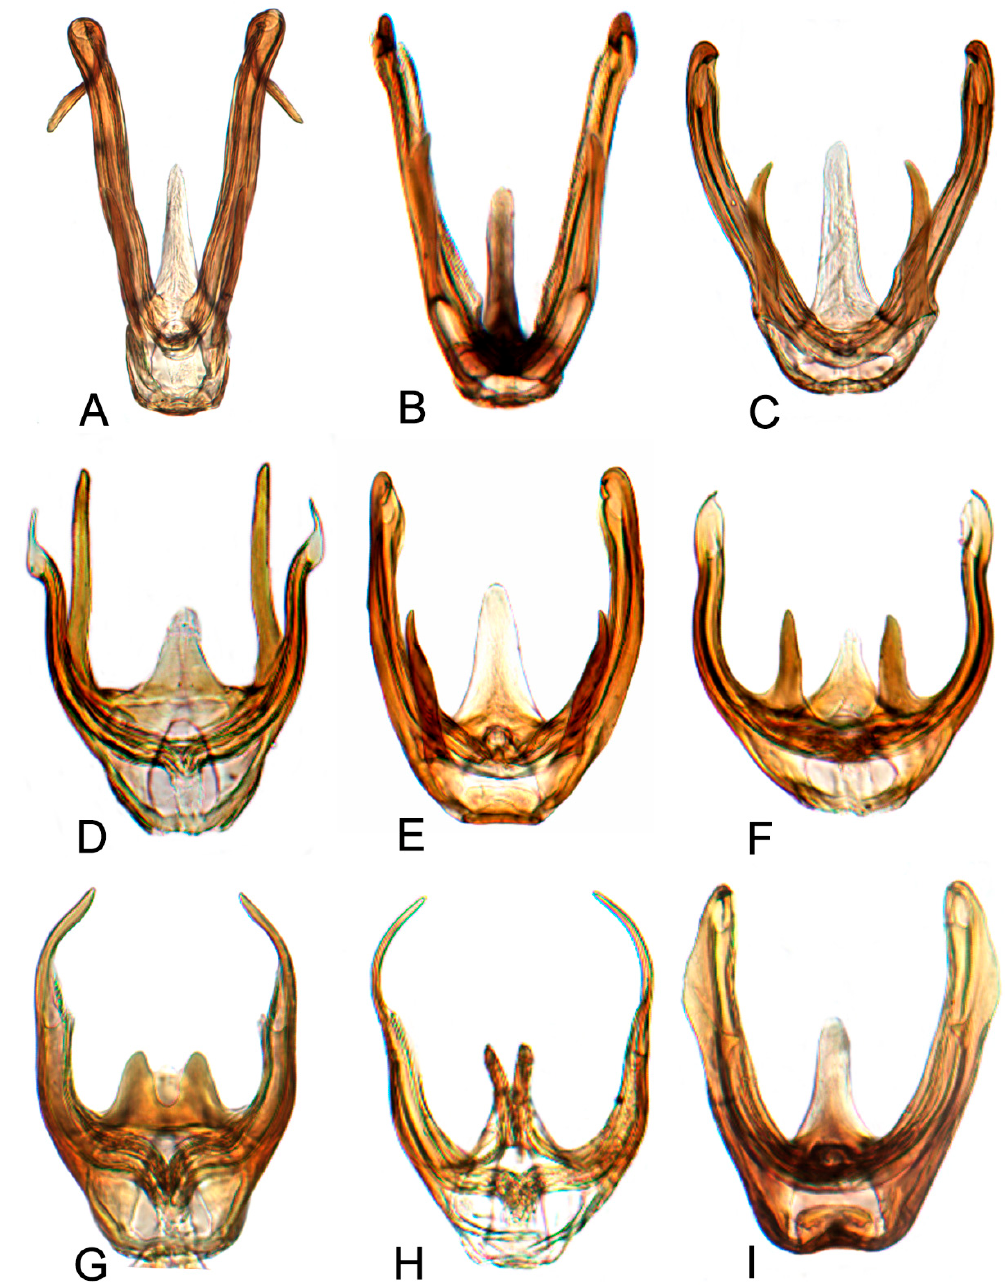
Figure 17. Aedeagus, posterior view. ( A ) H. prolongatus ; ( B ) H. spiniferous ; ( C ) H. kuohi ; ( D ) H. tortuosus ; ( E ) H. aberrans ; ( F ) H. knightiellus ; ( G ) H. tenuis ; ( H ) H. subtilis ; and ( I ) H. di ff ractus .